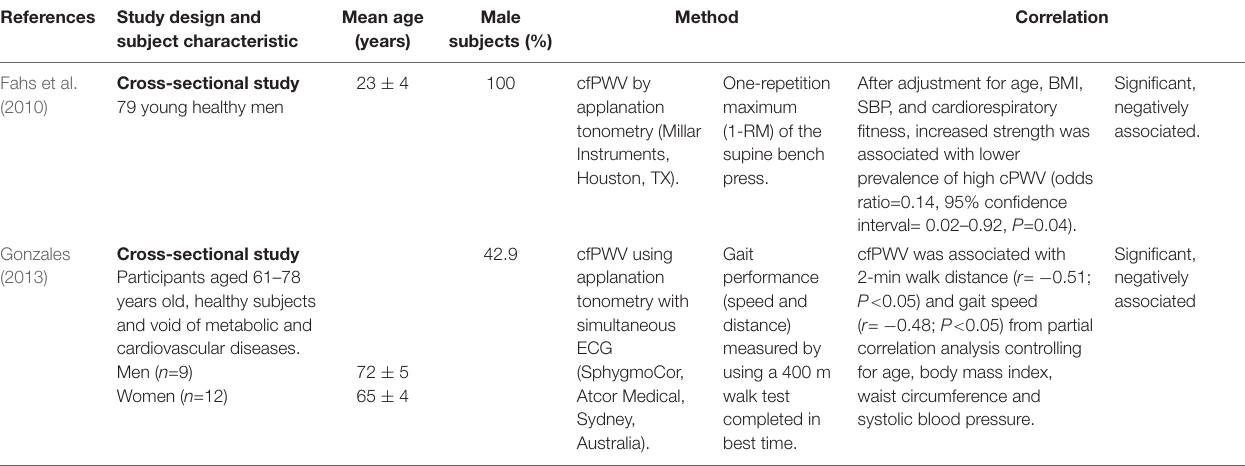
TABLE 1 | Selected studies focusing on the association between arterial stiffness and muscle strength in healthy